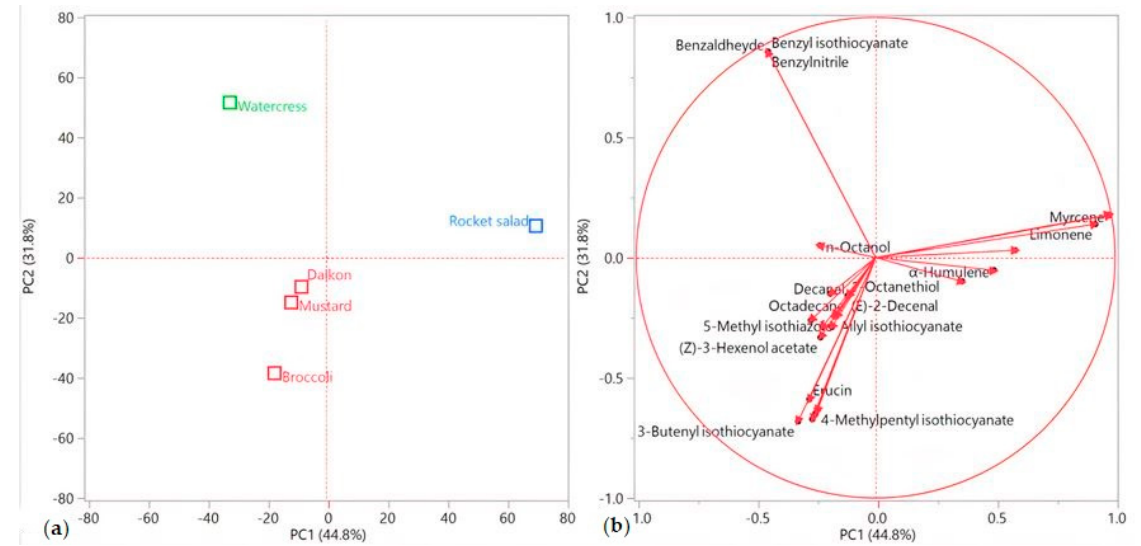
Figure 3. Score ( a ) and loadings ( b ) plots obtained using the principal component analysis performed on the complete EO compositions for all of the analyzed species.